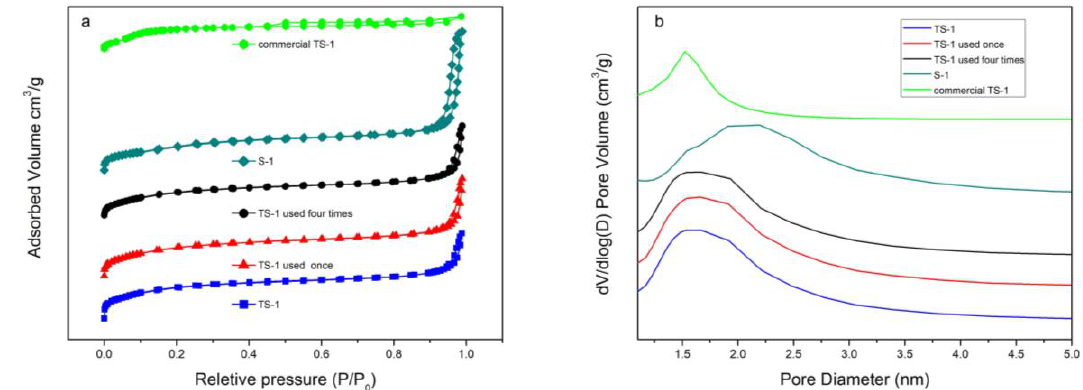
Figure 9. N 2 adsorption-desorption isotherms ( a ) and pore diameter distribution ( b ) of TS-1, used TS-1, S-1, and commercial TS-1. Table 2. Structural properties of the samples.